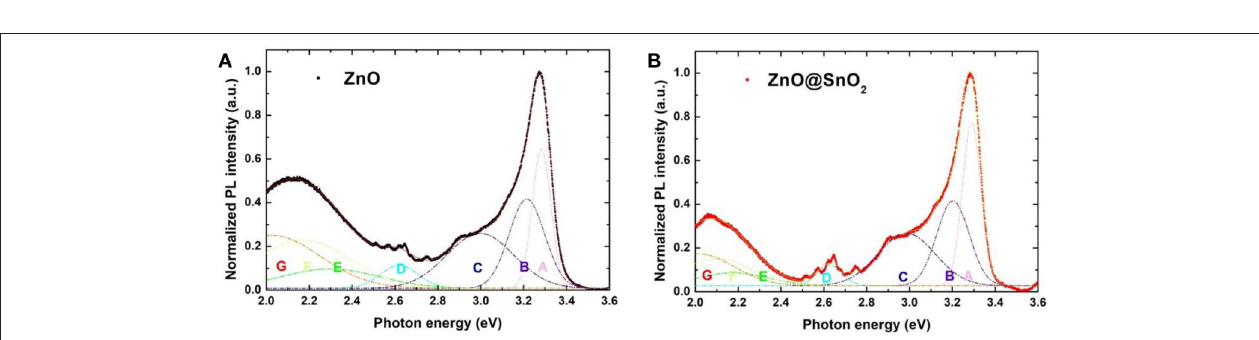
by PYS technique (see Figure 4B and Figure S3 ). The VBM values of ZnO NWs, ZnO@SnO 2 NWs, and PbS CQDs, which are determined by the intersection of the tangent line